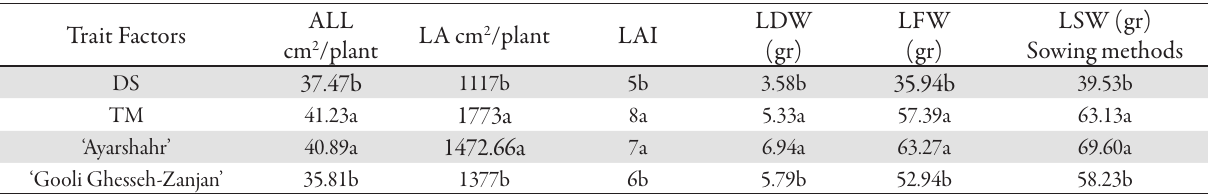
Tab. 7. Mean comparison effects of sowing methods and cultivars on length of the aerial leaves, leaf area, leaf area index, saturation/dry/fresh weight